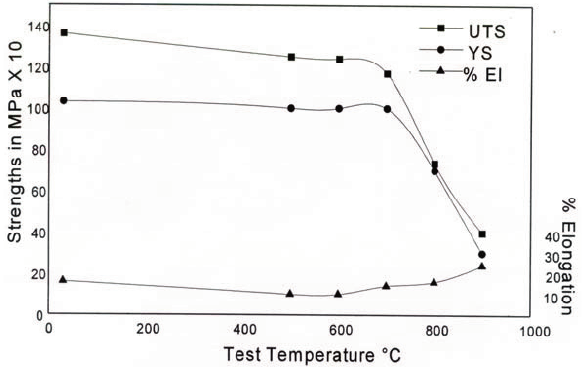
Figure 4. Mechanical properties of forged and heat treated bars at different temperatures and strain rates.